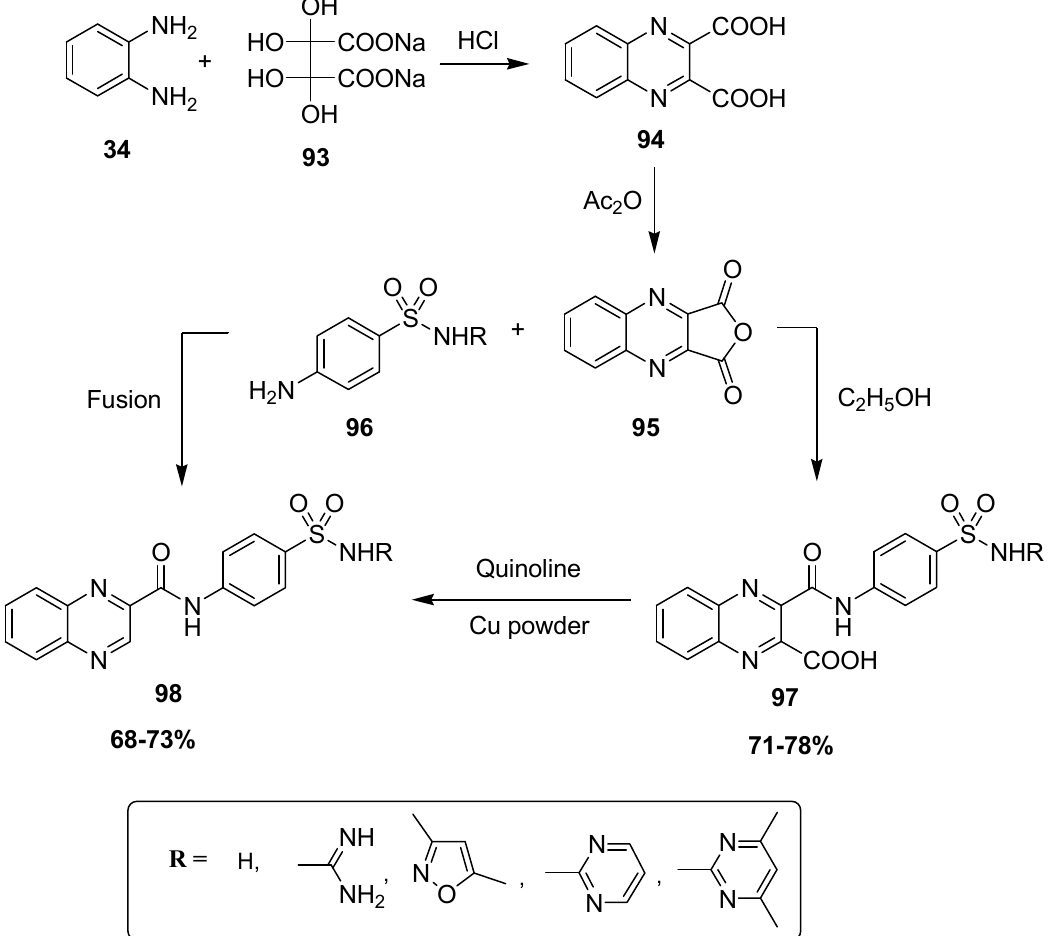
acid 94 was produced by the treatment of OPD 34 with disodium dihydroxytartarate 93 , followed by a reaction with acetic anhydride, which resulted in the formation of quinoxa- line anhydride derivative 95 . The scaffold 95 was refluxed with substituted sulfonamide 96 in ethanol to afford 3-sulfamoyl phenylcarbamoyl quinoxaline-2-carboxylic acids 97 at 71–78% yield, which further reacted in quinoline-containing copper powder to obtain cor- responding quinoxaline sulfonamide scaffold 98 . The quinoxaline sulfonamide derivative 98 was also prepared at 68–73% yield by directly heating the anhydride compound 95 with sulfonamide compound 96 under fusing conditions (Scheme 9) [135].